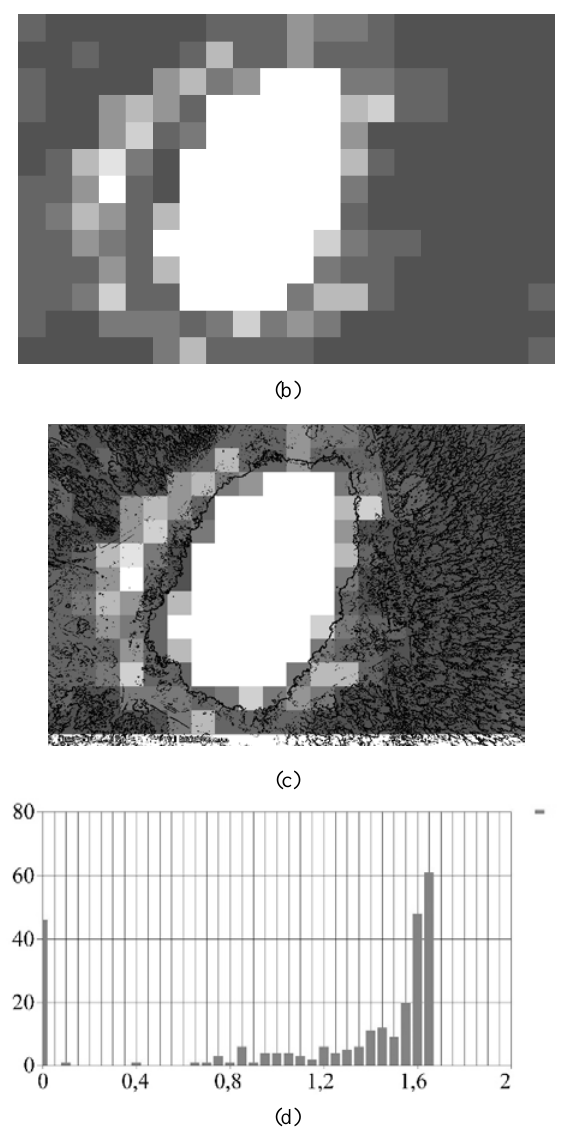
Fig. 1. The results of fractal image analysis (image size 800 × 541; fractal dimension D estimation display field size - 40): (a) - the original image; (b) - fractal dimension sheet; (c) - combined image; (d) - histogram of the fractal image